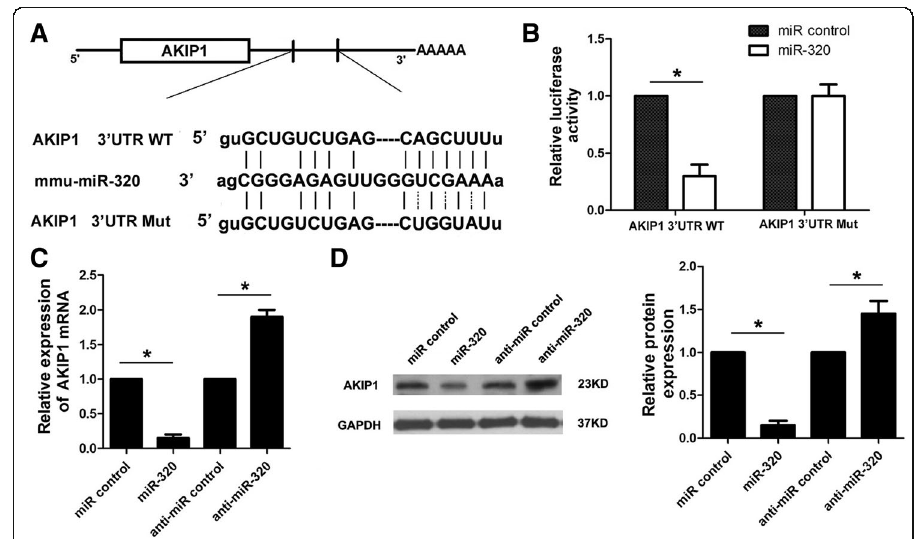
Fig. 3 MiR-320 directly targets AKIP1. a Predicted binding sequences of miR-320 in AKIP1 3 ′ UTR. A fragment of wild-type (wt) or mutant (mut) 3 ′ UTR of AKIP1 was subcloned into the luciferase reporter vector. b H9c2 cells were co-transfected with miR-320 mimics and luciferase reporters that contained the predicted miRNA target site in the AKIP1 mRNA 3 ′ UTR or its corresponding mutant form. The cells co-transfected with miR control and luciferase reporters were used as the control group. The expression levels of AKIP1 mRNA and protein were measured by qRT-PCR ( c ) and Western blot ( d ), respectively. * P <